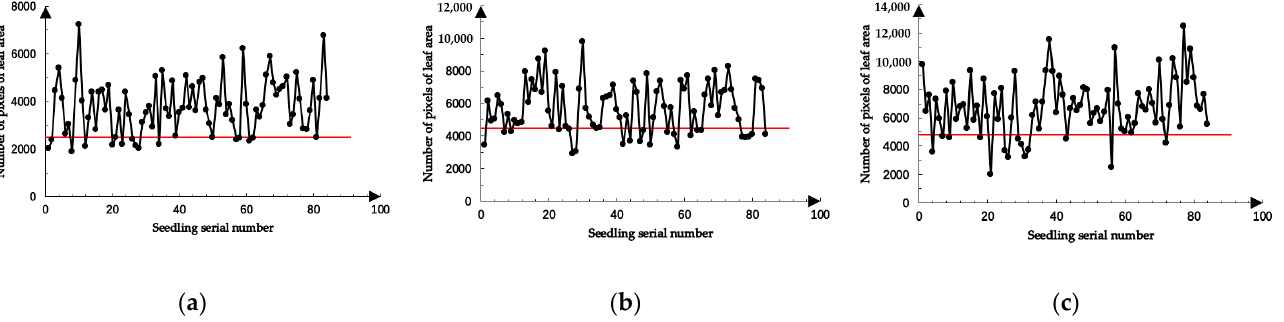
Figure 11. Lettuce leaf area of different seedling ages: ( a ) Seedlings at age 17 d; ( b ) seedlings at age 20 d; ( c ) seedlings at age 22 d.